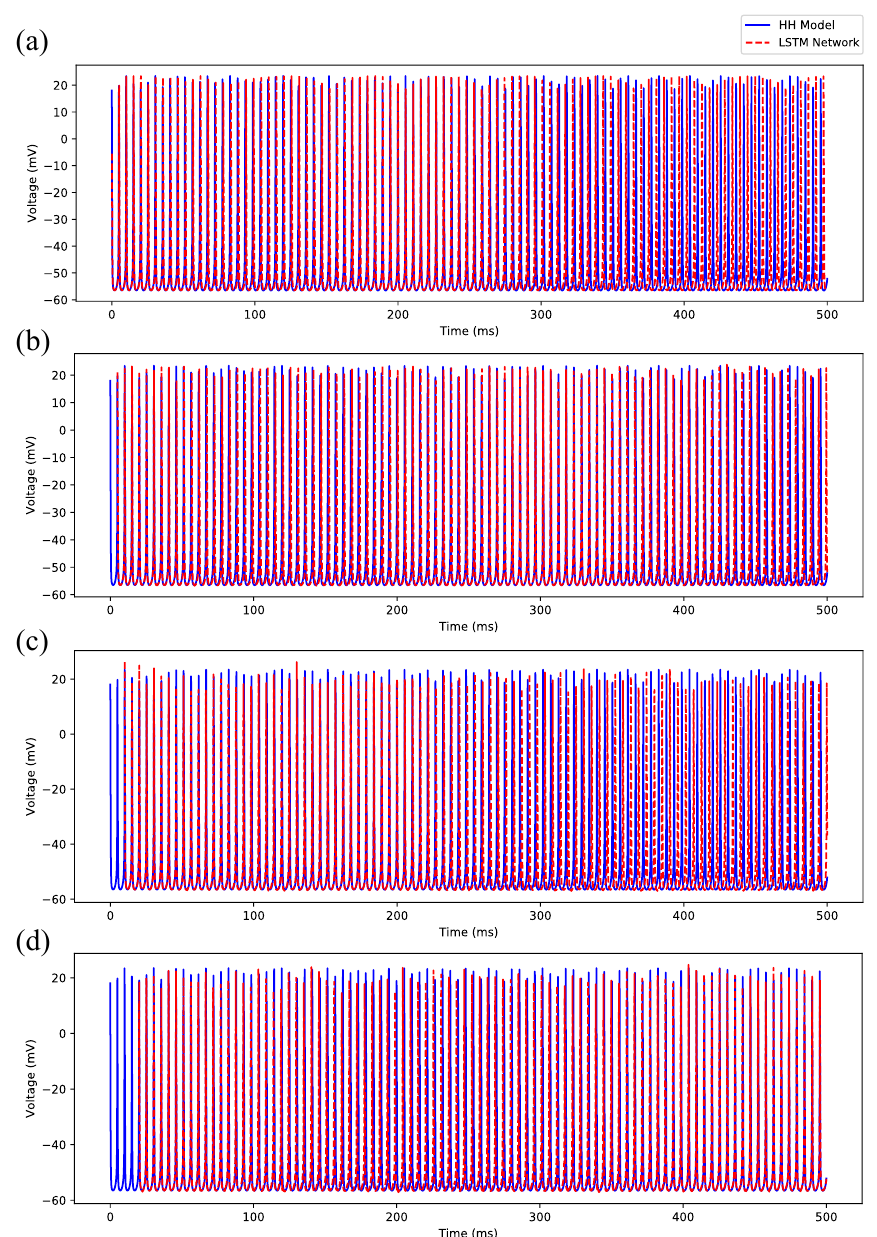
Figure 7. Comparison of predicted membrane potential traces by the deep LSTM neural network (“LSTM Network”) to the regular spiking pattern exhibited by the Hodgkin-Huxley model (“HH Model”) in response to the external stimulating current I = 3.0 nA. ( a ) Prediction using 1 timestep predictive LSTM network ( N p = 1). ( b ) Prediction using 50 timesteps predictive LSTM network ( N p = 50). ( c ) Prediction using 100 timesteps predictive LSTM network ( N p = 100). ( d ) Prediction using 200 timesteps predictive LSTM network ( N p =